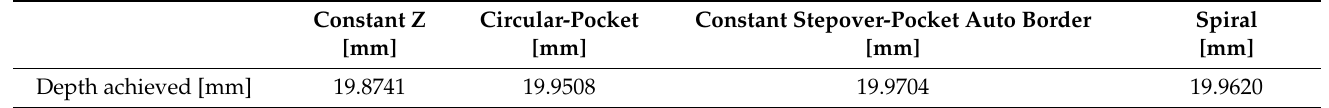
Table 7. Depth comparison for individual parts.